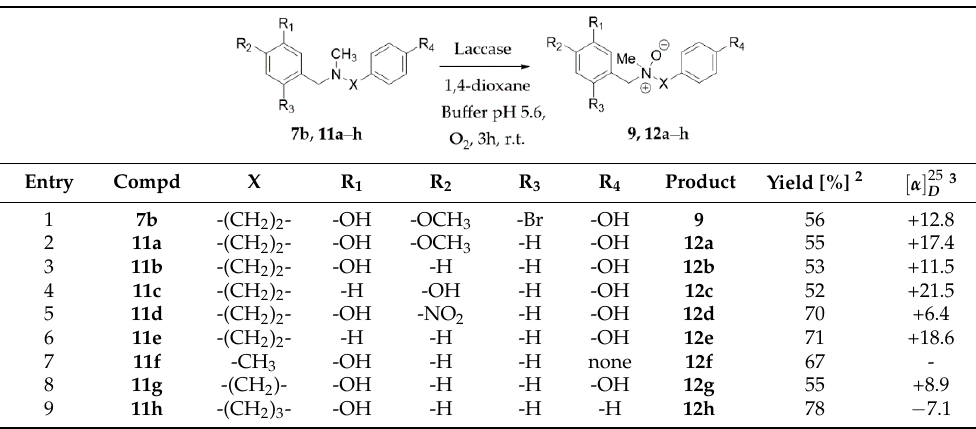
Table 2. Synthesis of belladine N -oxide derivatives 9 and 12a – h 1.